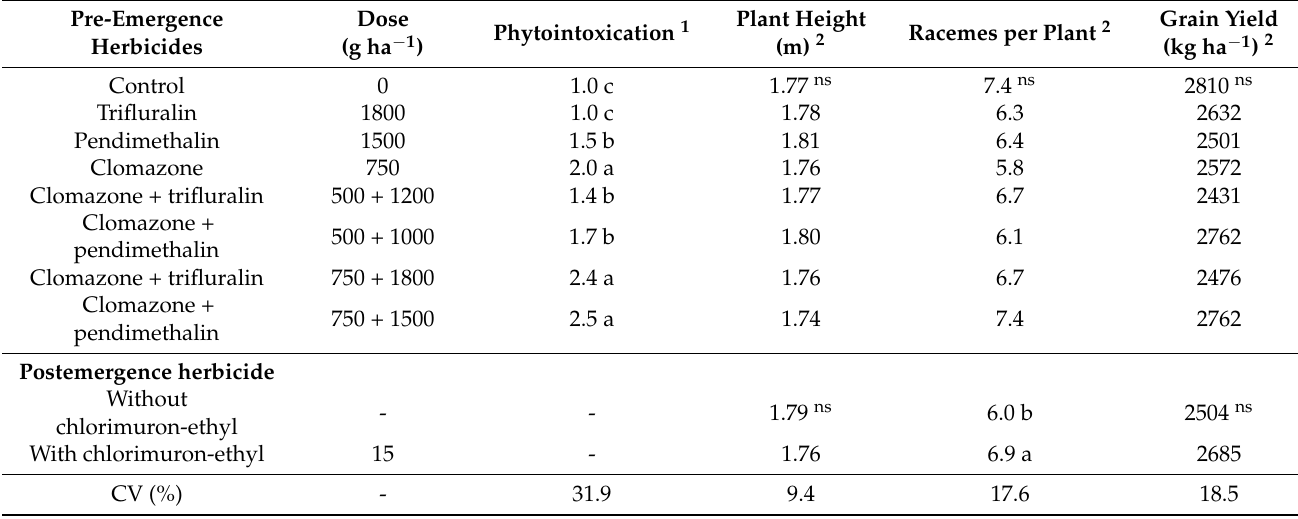
Table 1. Phytointoxication, plant height, racemes per plant, and seed yield of castor ( Ricinus communis L.) under weed management combining pre- and postemergence